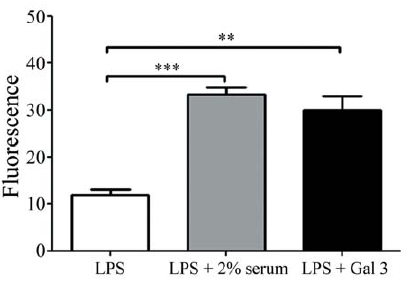
Figure 6. Gal 3/LPS interaction enhances the fluorescence of FITC-LPS. FITC-labeled E. coli LPS (10 m g/ml) was incubated with 4 m M Gal 3 or 2% serum for 2 hours, and then applied to a gel filtration column (Superdex TM 75 HR 10/30 column). FITC-LPS alone or Gal 3 alone were also analyzed. 0.5 ml fractions of FITC-LPS 6 Gal 3 or 6 2% serum were collected and further analyzed on a fluorescence microplate reader. The excitation and emission wavelengths were at 475 nm and 520 nm, respectively. Data represents the fluorescence of the main peak of FITC-LPS recovered in the void volume. ** p , 0.01, ***p ,